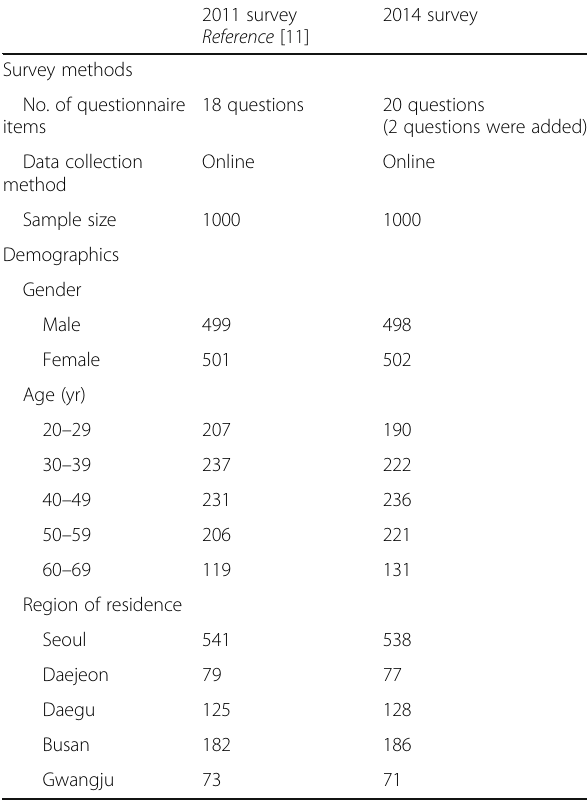
Table 1 Survey methods and demographic profiles of the